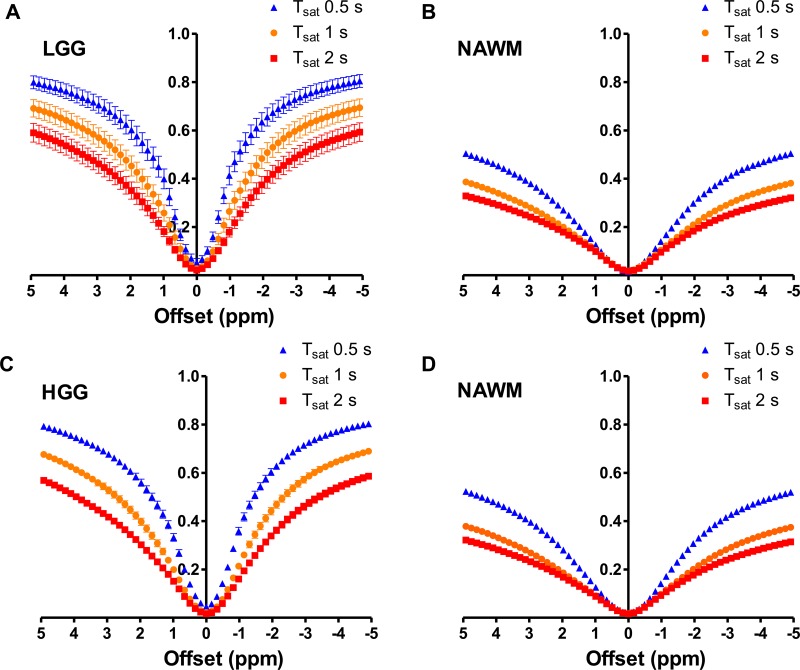
Z-spectra of LGG (A), HGG (C), and corresponding NAWM (B, D). Z-spectra of tumor was steeper than that of NAWM, presumably because of less MT effect in tumor compared with NAWM. Prolongation of saturation pulses results in larger MT effect and thus wider Z-spectra in both tumor and NAWM.